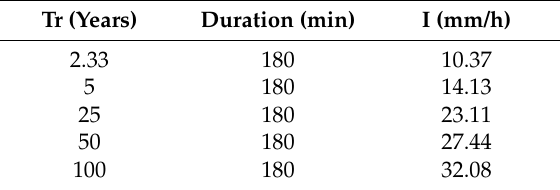
Table 2. Calculated rainfall intensities using Equation (1) for Jeddah city in KSA. Tr (Years)